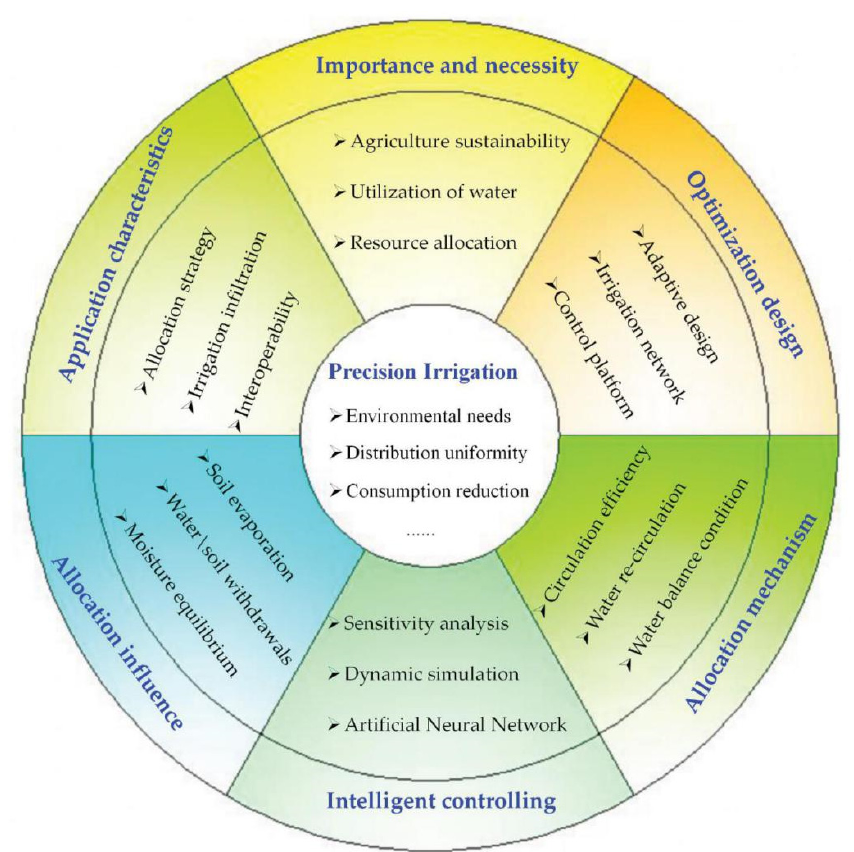
Figure 2. The inclusive subjects discussed in integrative management effectiveness of precision irrigation.